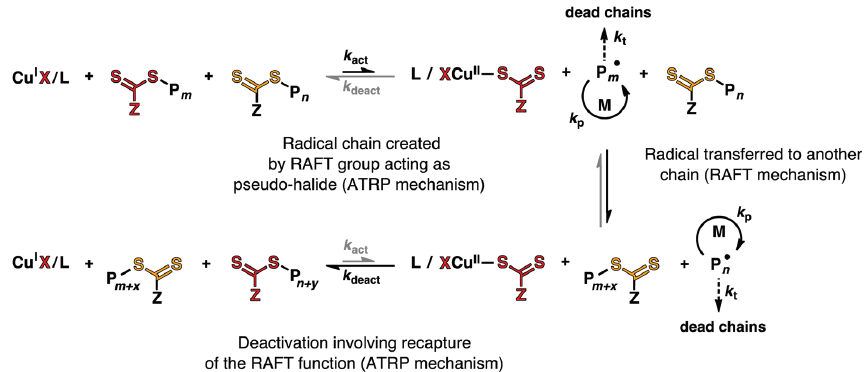
Figure 5. Concurrent ATRP and reversible addition-fragmentation chain-transfer polymerization (RAFT) mechanism. Adapted with permission from [20], Copyright© 2017 Royal Society of Chemistry.